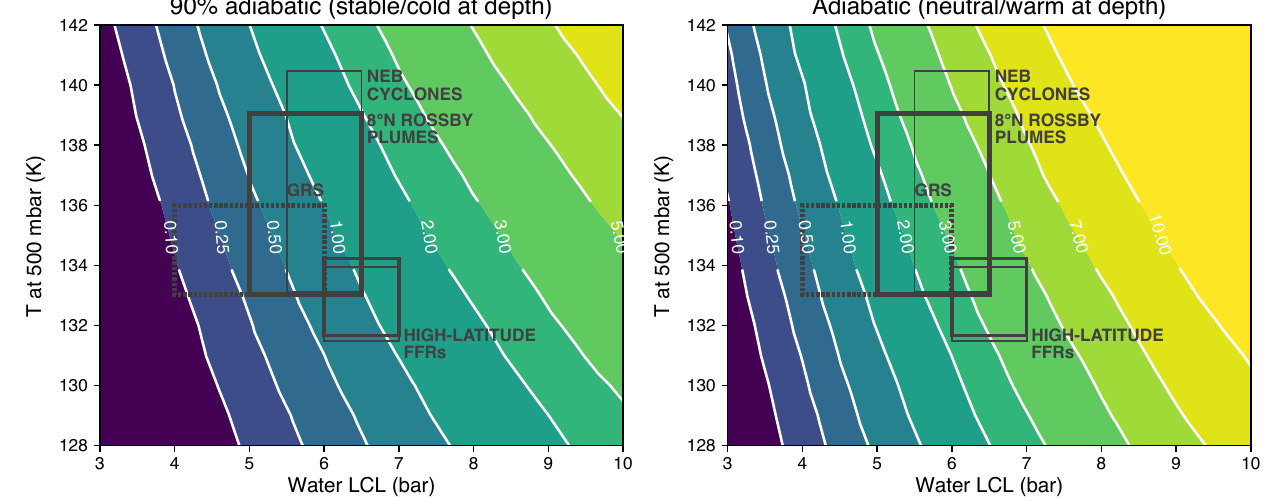
Figure 22. Water abundance as a function of LCL and 500-mbar temperature, as in Figure 17, with “cloud box” overlays for deep clouds in selected locations (see Table 3). Retrieved cloud top pressures from Bjoraker et al. [11] for four features are overlaid as grey boxes with solid lines: two folded filamentary regions (FFRs) at high latitudes, a pair of cyclonic vortices in the NEB, and deep clouds associated with Rossby plumes at the EZ/NEB boundary. The full range of temperatures at the same latitude taken from Figure 21 is given by the vertical extent of each cloud box. For the GRS (dashed grey box), cloud top pressures are from Bjoraker et al. [44] and 500-mbar temperatures are from Simon-Miller et al. [145] and Fletcher et al. [143,144]. A strict limit of O/H > 0.5 × protosolar is set by the lower left corners of the boxes located furthest to the right in the left panel. A more relaxed lower limit of O/H > 1–3 × protosolar is indicated by the centers of the cloud boxes in both panels. The range tightens to 1–2 × protosolar when taking into account theoretical arguments that temperature profiles within anticyclones should be closer to neutrally stable, while cyclones should have greater static stability [7,8,131,132]. These arguments imply that the right panel is more appropriate for the GRS and the left panel is more appropriate for the NEB cyclones and high-latitude FFRs, with 1 × protosolar water (at the cloud base level) being the likely lower limit for both cyclonic and anticyclonic vortices. Cloud top heights can only give lower limits, because p top < LCL, and the abundance constraint comes from the LCL, not the observable p top